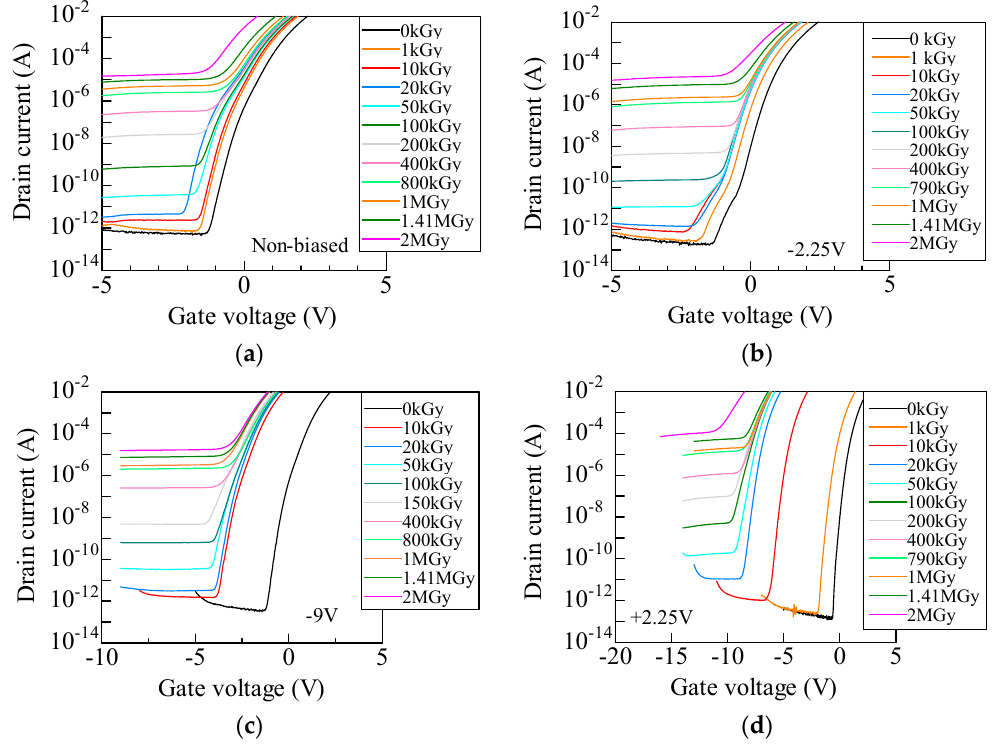
Figure 1. I D – V G curves in the subthreshold region for irradiated SiC MOSFETs for ( a ) unbiased, ( b ) − 2.25 V, ( c ) − 9 V, and ( d ) +2.25 V. These were measured applying a drain voltage of 10 V.